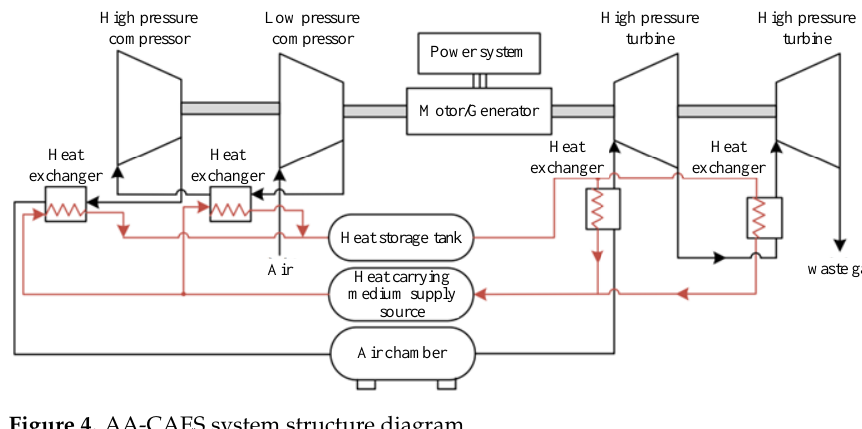
Figure 4. AA-CAES system structure diagram.